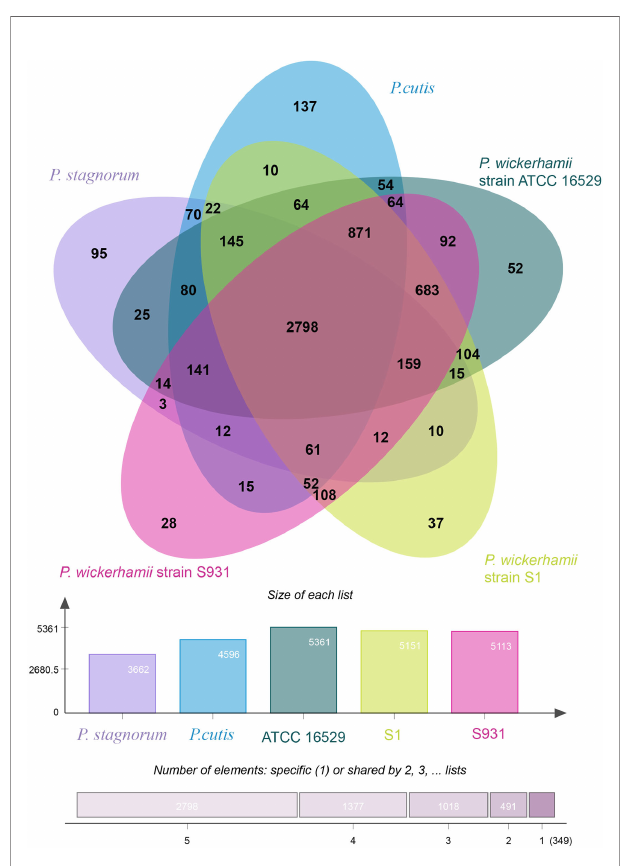
FIGURE 2 | Distribution of gene families in P. wickerhamii strain S1, P. wickerhamii strain S931, P. wickerhamii strain ATCC 16529, P. cutis, and P. stagnorum . Homologous genes in the fi ve species were clustered into gene families. Numbers indicate unique and shared gene families in each species.